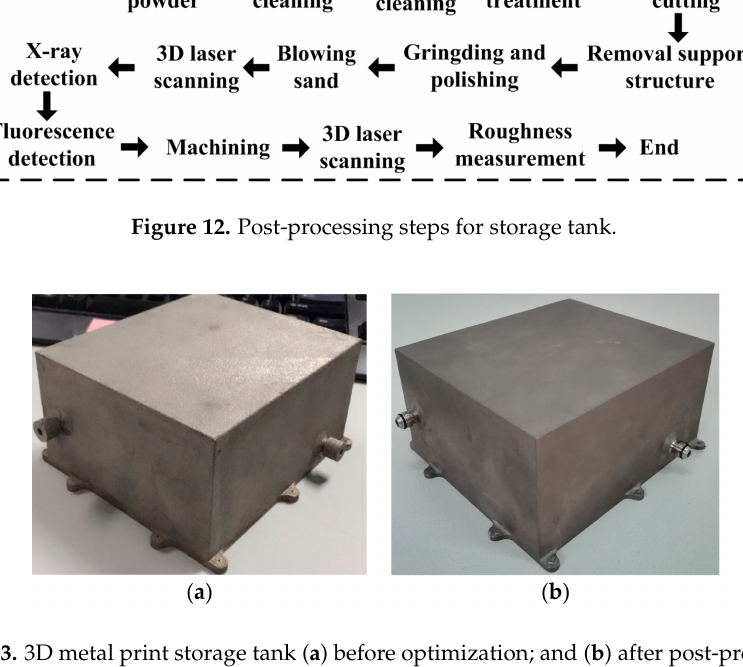
Figure 13. 3D metal print storage tank ( a ) before optimization; and ( b ) after post-processing. Table 12. Comparison of structural performance of storage tank before and after